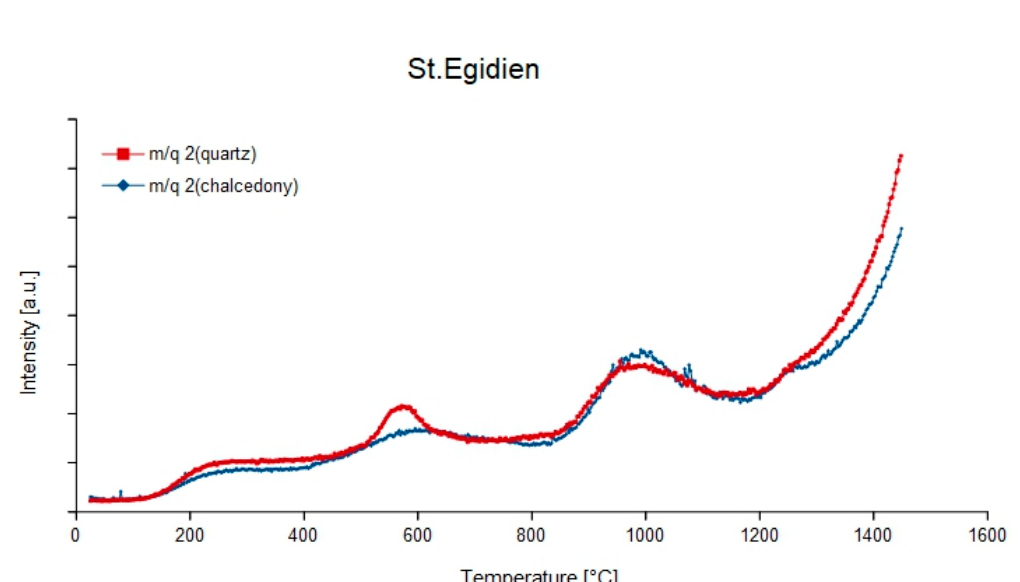
Figure 3. Temperature dependent degassing curves of the mass-charge ratio 2 ( 1 H 2 ) of quartz and chalcedony in agate from St. Egidien, Germany.